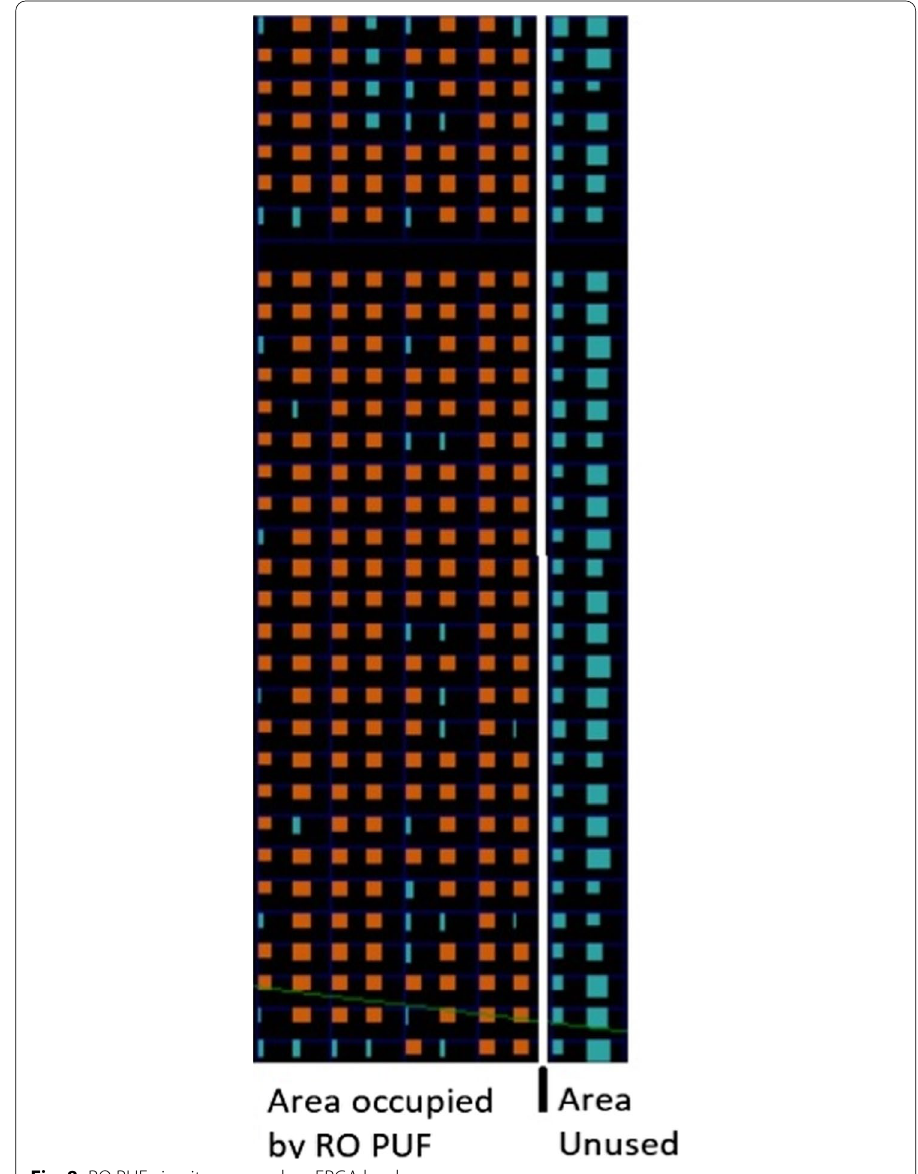
Fig. 8 RO PUF circuits arranged on FPGA hardware